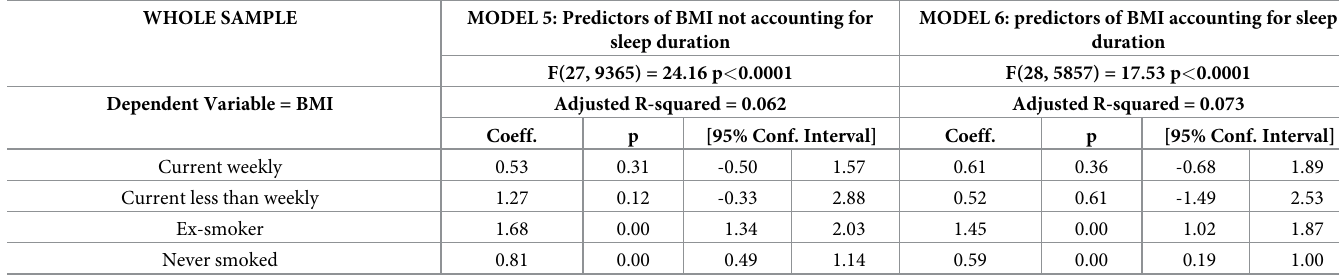
MODEL 5: Predictors of BMI not accounting for sleep duration